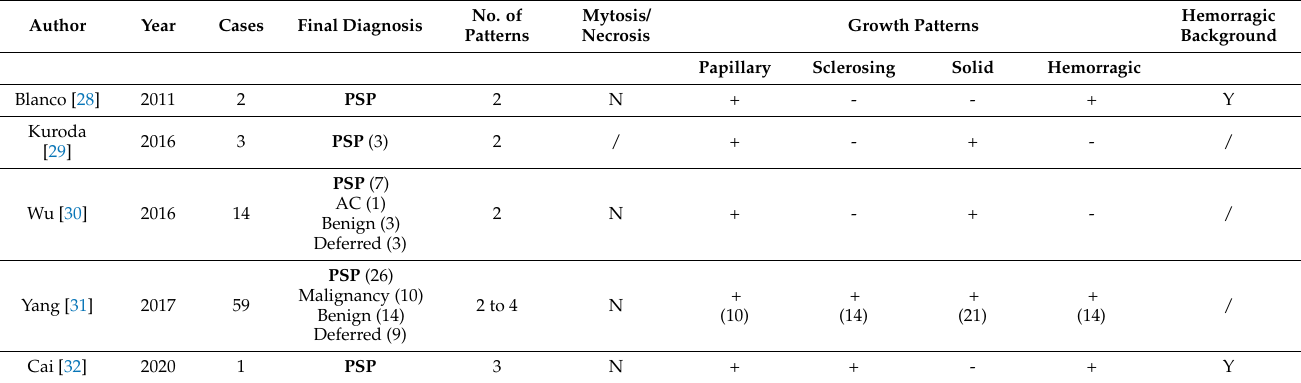
Table 4. Summary of the PSP cytological findings in frozen sections described in literature in the last 10